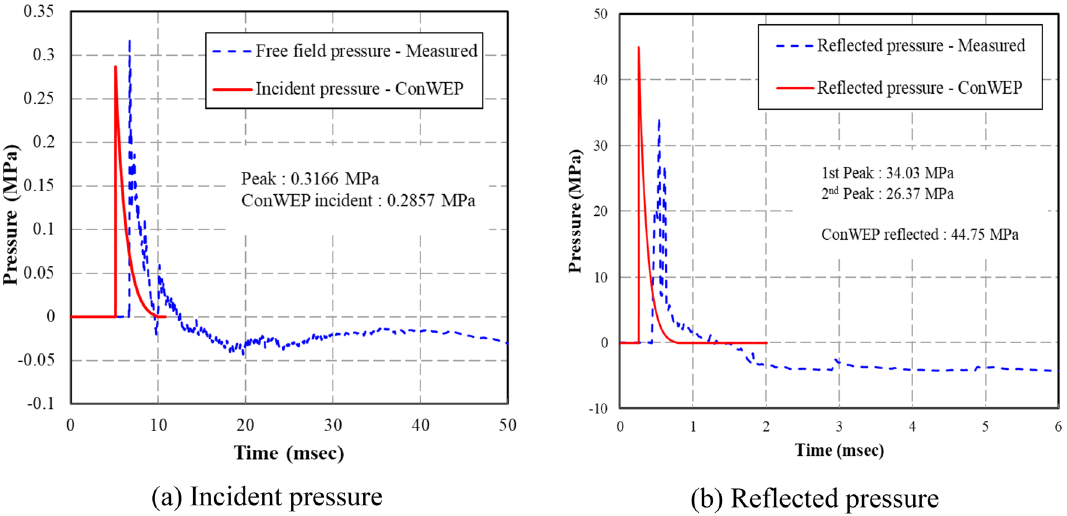
Figure 8. Blast pressure results of ANFO 15.88 kg. ( a ) Incident pressure. ( b ) Reflected